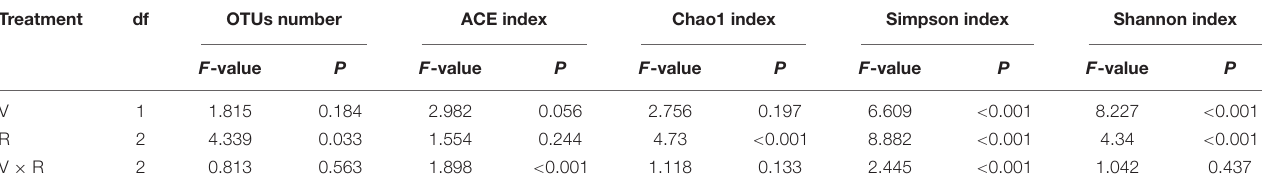
FIGURE 1 | Diversity indices of seed-borne fungal communities of different varieties and regions of oat. (A) OTU number. (B) ACE index. (C) Chao1 index. (D) Simpson index. (E) Shannon index. Values are means ± standard error (SE), and bars indicate SE. Different lowercase letters stand for significant differences at 0.05 level. TABLE 2 | Results of two way ANOVA for the effects of varieties (V) and regions (R) on diversity indexes of seed-borne fungal communities in oat.